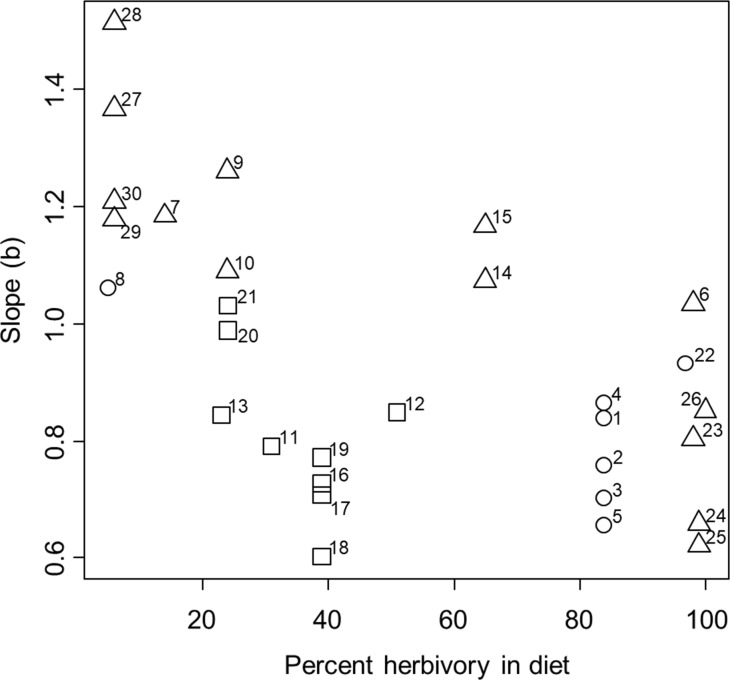
Relationship between the slope of the ontogenetic allometric relationship between log stomach volume and log dry body mass and several ecological factors.Percent herbivory in the diet is shown on the x-axis. Activity levels of crabs were binned for graphical presentation and are shown by the symbol shape, with squares indicating species that are relatively inactive, circles indicating species that are moderately active, and triangles indicating species that are highly active. Numbers next to symbols indicate the species/gender/habitat as follows: 1 –A. pisonii mangrove male; 2 –A. pisonii mangrove female; 3 –A. pisonii marsh male; 4 –A. pisonii marsh female; 5 –A. pisonii dock; 6 –A. cinereum; 7 –C. sapidus; 8 –C. irroratus; 9 –C. maenas male; 10 –C. maenas female; 11 –D. sayi; 12 –E. depressus; 13 –E. limosum; 14 –H. sanguineus male; 15 –H. sanguineus female; 16 –P. herbstii male; 17 –P. herbstii female; 18 –P. obesus male; 19 –P. obesus female; 20 –R. harrisii male; 21 –R. harrisii female; 22 –S. reticulatum; 23 –U. minax; 24 –U. pugilator male; 25 –U. pugilator female; 26 –U. pugnax; 27 –O. quadrata pristine; 28 –O. quadrata medium human impact; 29 –O. quadrata high human impact; 30 –O. quadrata high human impact + vehicles.